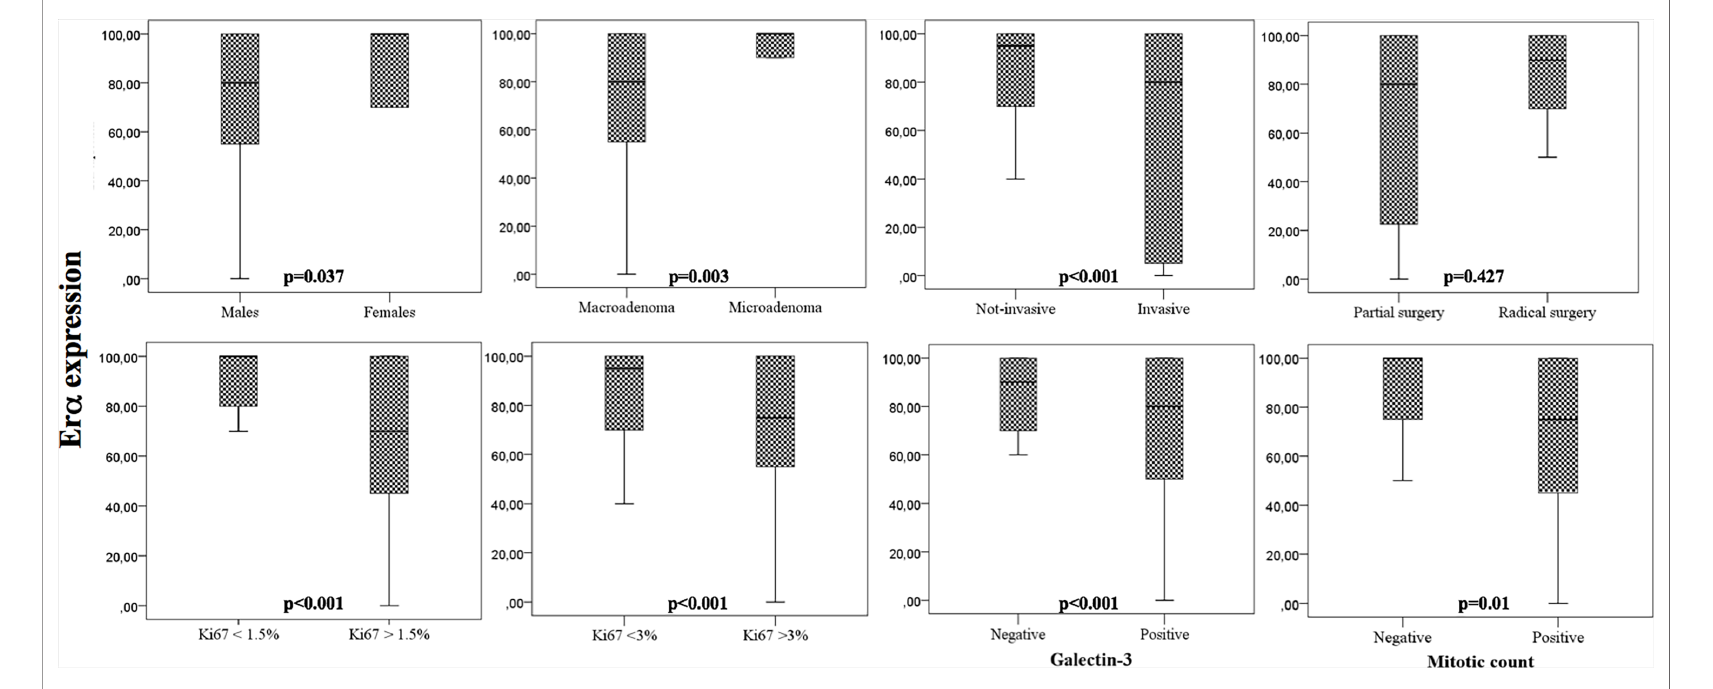
FIGURE 1 | Box-plots that show the expression of ER a according to clinical and pathological parameters. Univariate analysis.